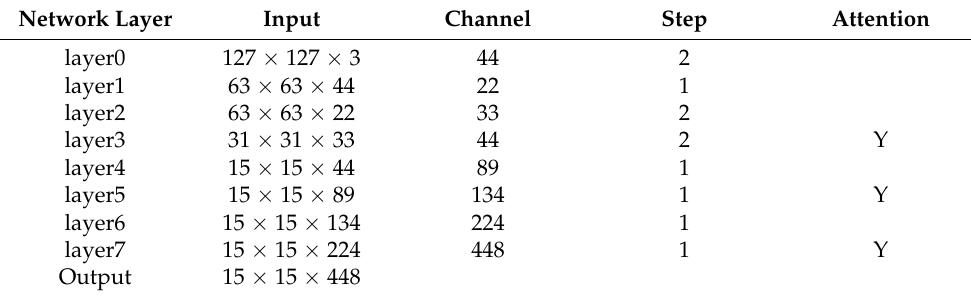
Table 2. Feature extraction backbone network